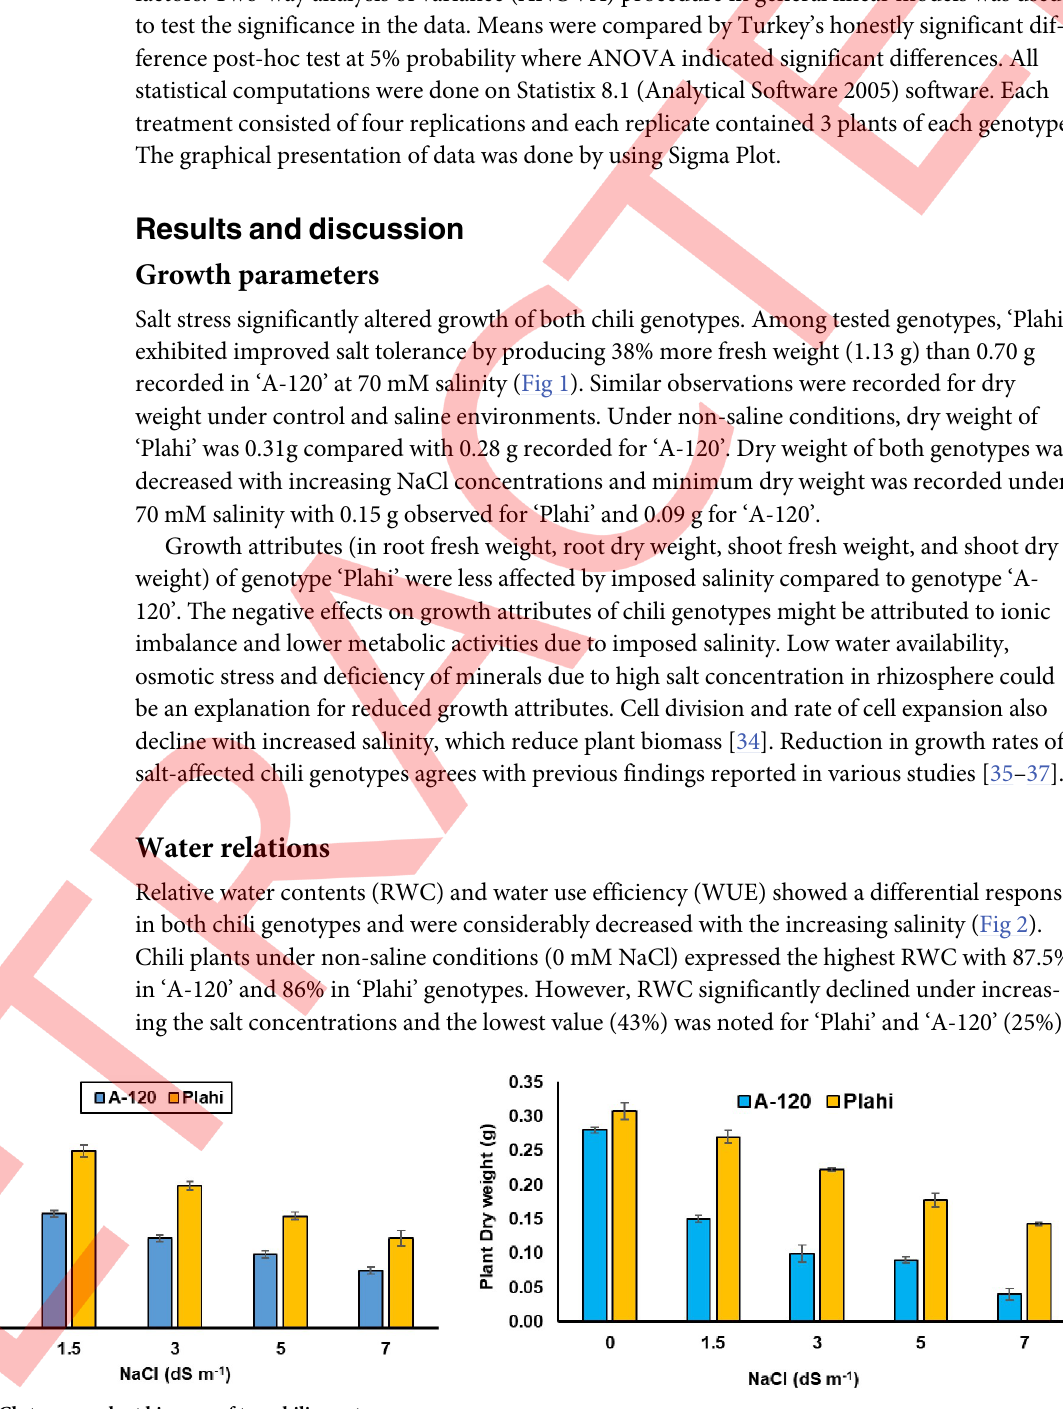
Fig 1. Effect of NaCl stress on plant biomass of two chili